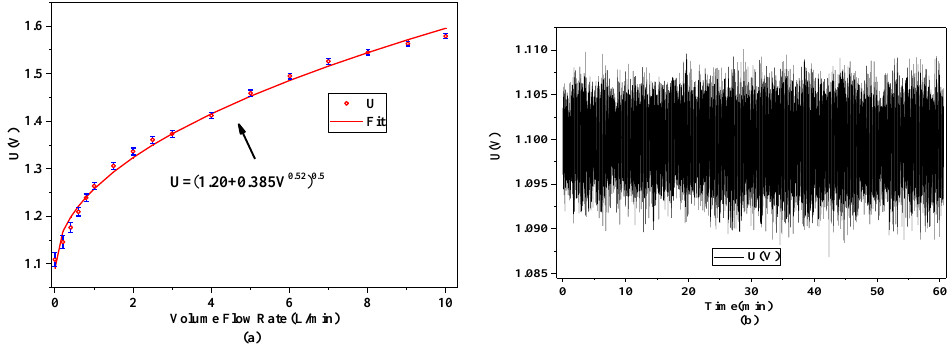
Figure 9. ( a ) Calibration of airflow sensor; and ( b ) stability of the sensor.